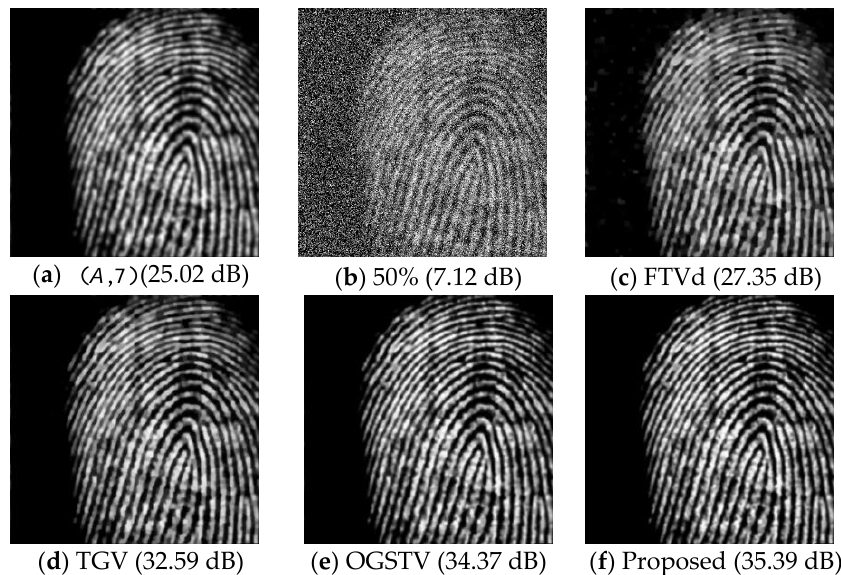
Figure 8. Comparison of the visual effects and PSNRs of image restorations of the “Fingerprint” image degraded with an average blur kernel ( A ,7 ) and 50% impulse noise: ( a ) blurred image; ( b ) blurred image with 50% impulse noise; ( c ) FTVd-restored image; ( d ) TGV-restored image; ( e ) OGSTV-restored image; ( f ) proposed algorithm-restored image.